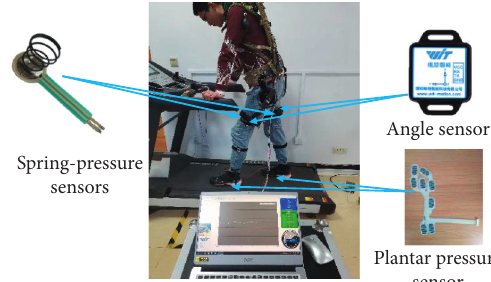
Figure 2: Exoskeleton